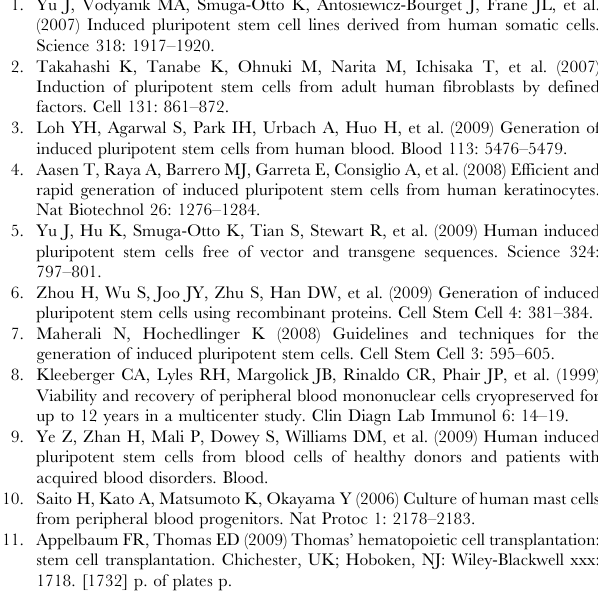
cells for all 15 allelic polymorphisms detected across the 8 STR loci analyzed. Representative data from two TiPS lines (TiPS L-1 and TiPS L-2) are shown. Found at: doi:10.1371/journal.pone.0011373.s001 (3.65 MB TIF) Figure S2 Alkaline Phosphatase (AP) Staining. TiPS lines TiPS L-1 and TiPS L-2 are AP positive. Images were acquired on an HP Scanjet G3110 computer scanner. Found at: doi:10.1371/journal.pone.0011373.s002 (2.87 MB TIF) Figure S3 TiPS cell lines display normal karyotype. TiPS cell lines ‘‘TiPS L-1’’ and ‘‘TiPS L-2’’ were grown for 6 passages on MEFs, and lines ‘‘TiPS V-1’’ and ‘‘TiPS V-2’’ were grown on Matrigel for 8 of 18 total passages and 30 of 34 total passages, respectively. Cells were subjected to G banding analysis and no clonal abnormalities were detected. Found at: doi:10.1371/journal.pone.0011373.s003 (4.70 MB TIF) Figure S4 Vector map of the MMLV retroviral construct used for reprogramming experiments. ‘‘RG’’ denotes reprogramming gene. Found at: doi:10.1371/journal.pone.0011373.s004 (1.91 MB